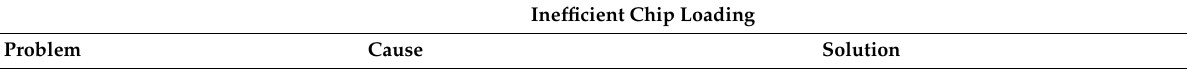
Table 3. Listed are the most frequently occurring challenges concerning inefficient chip loading with their respective cause and a suggested solution.